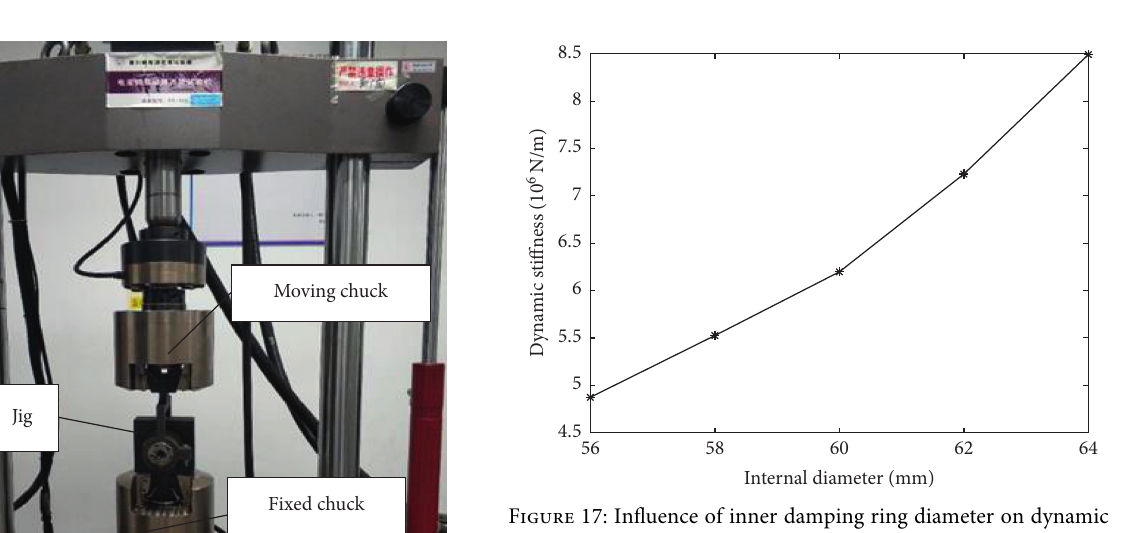
Figure 16: Hysteresis loop (4Hz and 0.7 mm excitation test).